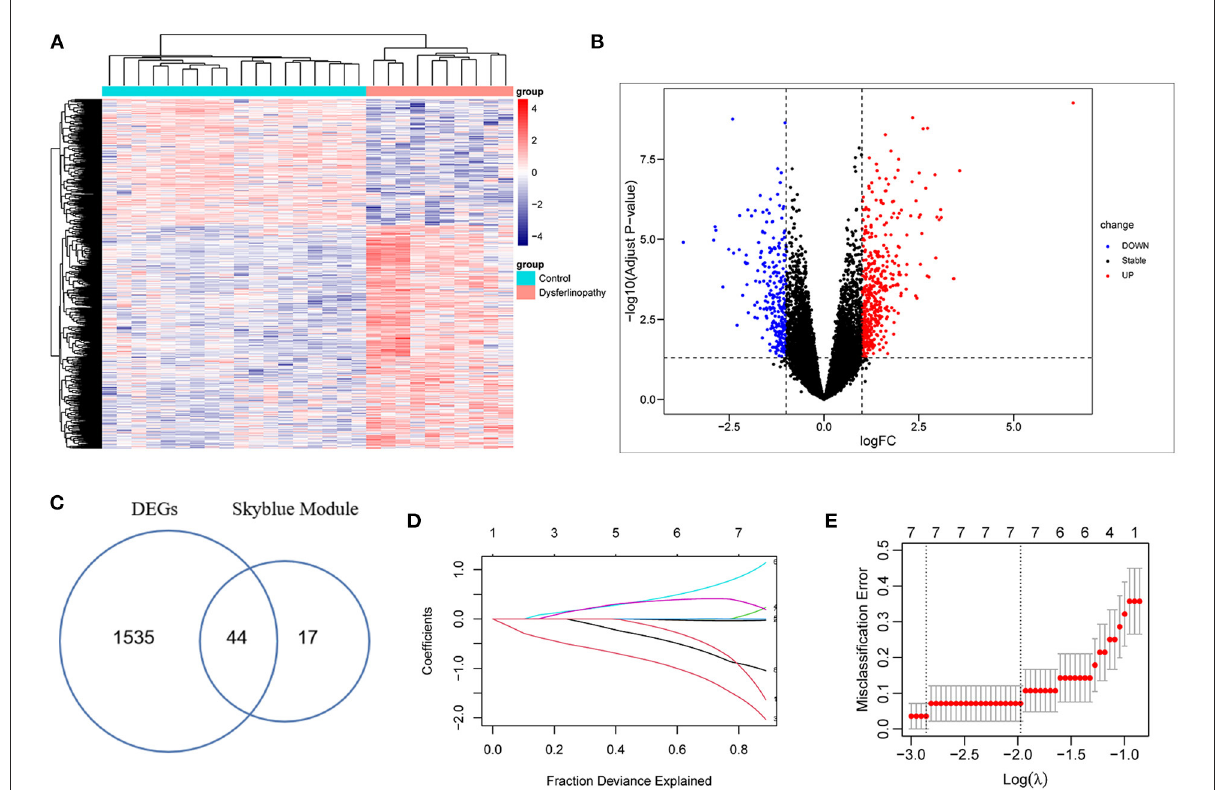
FIGURE3 Analysis of DEGs in GSE3307 dataset and screening of key genes. (A) Heat map of the DEGs in dysferlinopathy. (B) Volcano plot showing DEGs between dysferlinopathy muscles and normal controls. (C) Venn diagram for intersections between MEskyblue module and DEGs. (D) The partial likelihood deviance curve was plotted vs. log ( λ ) in 10-fold cross-validations. (E) Seven key genes screened by LASSO regression analysis in a cross-validation of 10